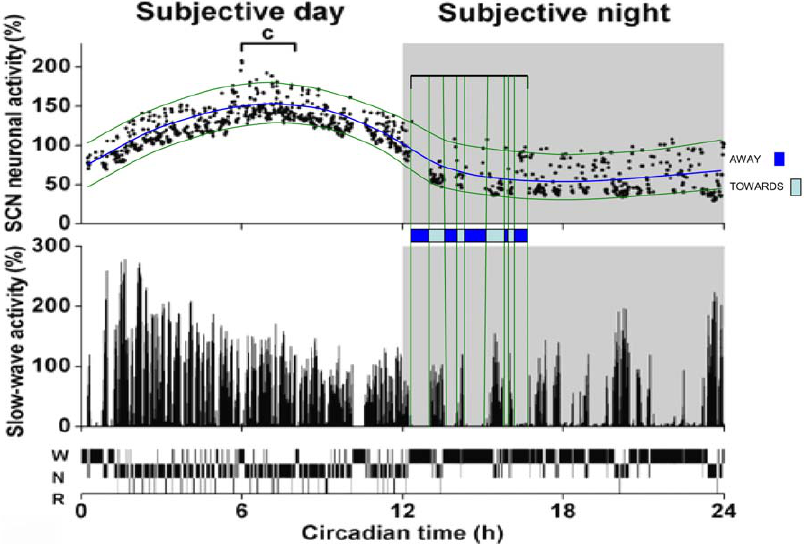
Figure 4. Vigilance states, slow-wave activity and SCN neuronal activity: 24 hour recording. SWA (EEG power density 1–4 Hz) and SCN neuronal activity are plotted as a percentage of the mean activity during NREM sleep over 24 h (each data point is the mean of 6 10-s epochs). The grey background indicates the subjective night (dark period) characterised by a lower level of SCN activity where the nocturnal rat is mostly active but exhibits short bouts of sleep. SWA shows high values during NREM sleep (N) and low values during REM sleep (R) and waking (W), adapted from Deboer et al. [35] with the kind permission of the publisher. The two green curves we added on the SCN activity figure enclose most of the data points. We also added about half way between these green lines a blue threshold line which separates SCN activity into two zones: one corresponding to a WAKE or REM level where SWA is about zero and the other to a NREM level where SWA is high. These zones correspond to the ‘ Away ’ and ‘ Towards ’ phases of the NTP model. The blue colour-coded bar above the SWA figure show the instants of transition of the SCN data across the threshold line, in either the upward or the downward direction. The inserted vertical green alignment lines facilitate the visualisation of simultaneity between transition events in the SCN activity and SWA.